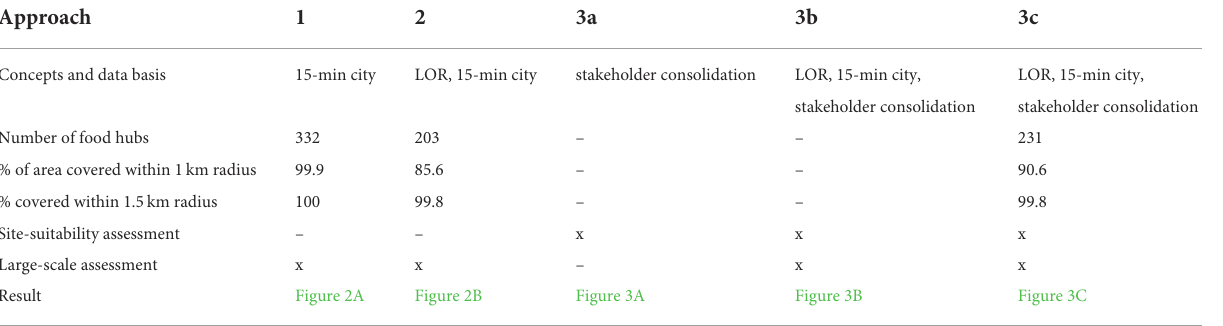
TABLE 2 Overview of the results the approaches described in Figure